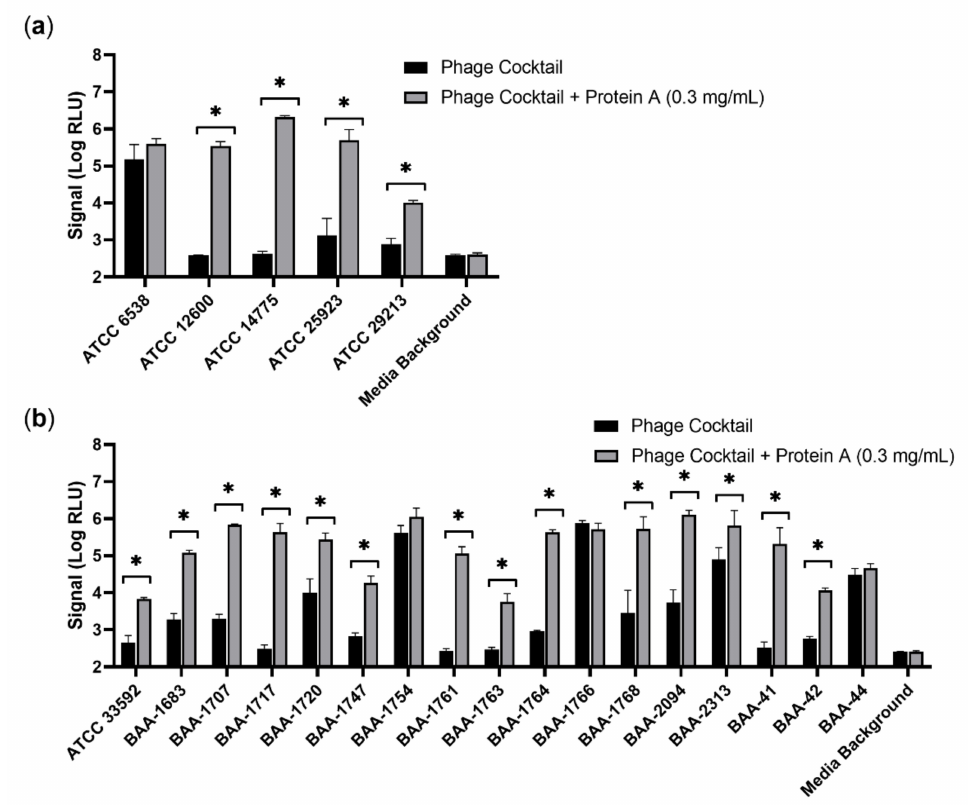
Figure 5. A modified phage cocktail containing recombinant protein A relieves serum suppression of signal broadly among S. aureus . A diverse panel of MSSA ( a ) and MRSA ( b ) strains were evaluated for luciferase production following a 4 h enrichment and a 2 h infection in the presence of 1% off- the-clot human serum. Initial inoculum was approximately 100 CFU per well. When indicated, recombinant protein A was included as part of a modified phage cocktail for the 2 h infection only. Signal is provided as log-transformed relative light units (Log RLU). Error bars represent standard deviation from triplicate wells. A two-way ANOVA with a Bonferroni’s multiple comparisons test was performed, comparing each sample in serum with and without protein A. Asterisks (*) indicate significance ( p <